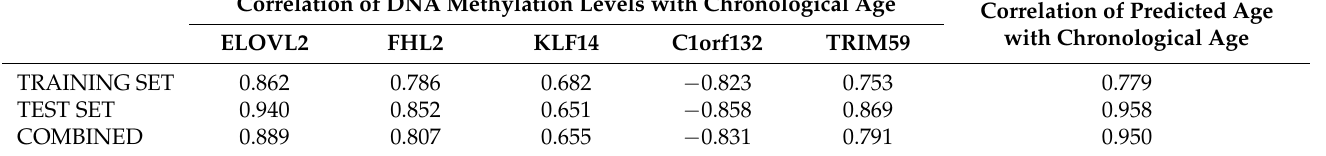
Table 1. Pearson correlation coefficient r of DNA methylation level variations with chronological age and predicted in each of the five loci studied, for the training, test, and combined datasets. Correlation for predicted age with chronological age in the three data sets is also